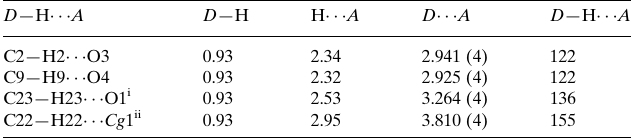
Hydrogen-bond geometry (A˚ , (cid:2) ). Cg 1 is the centroid of the C7–C12